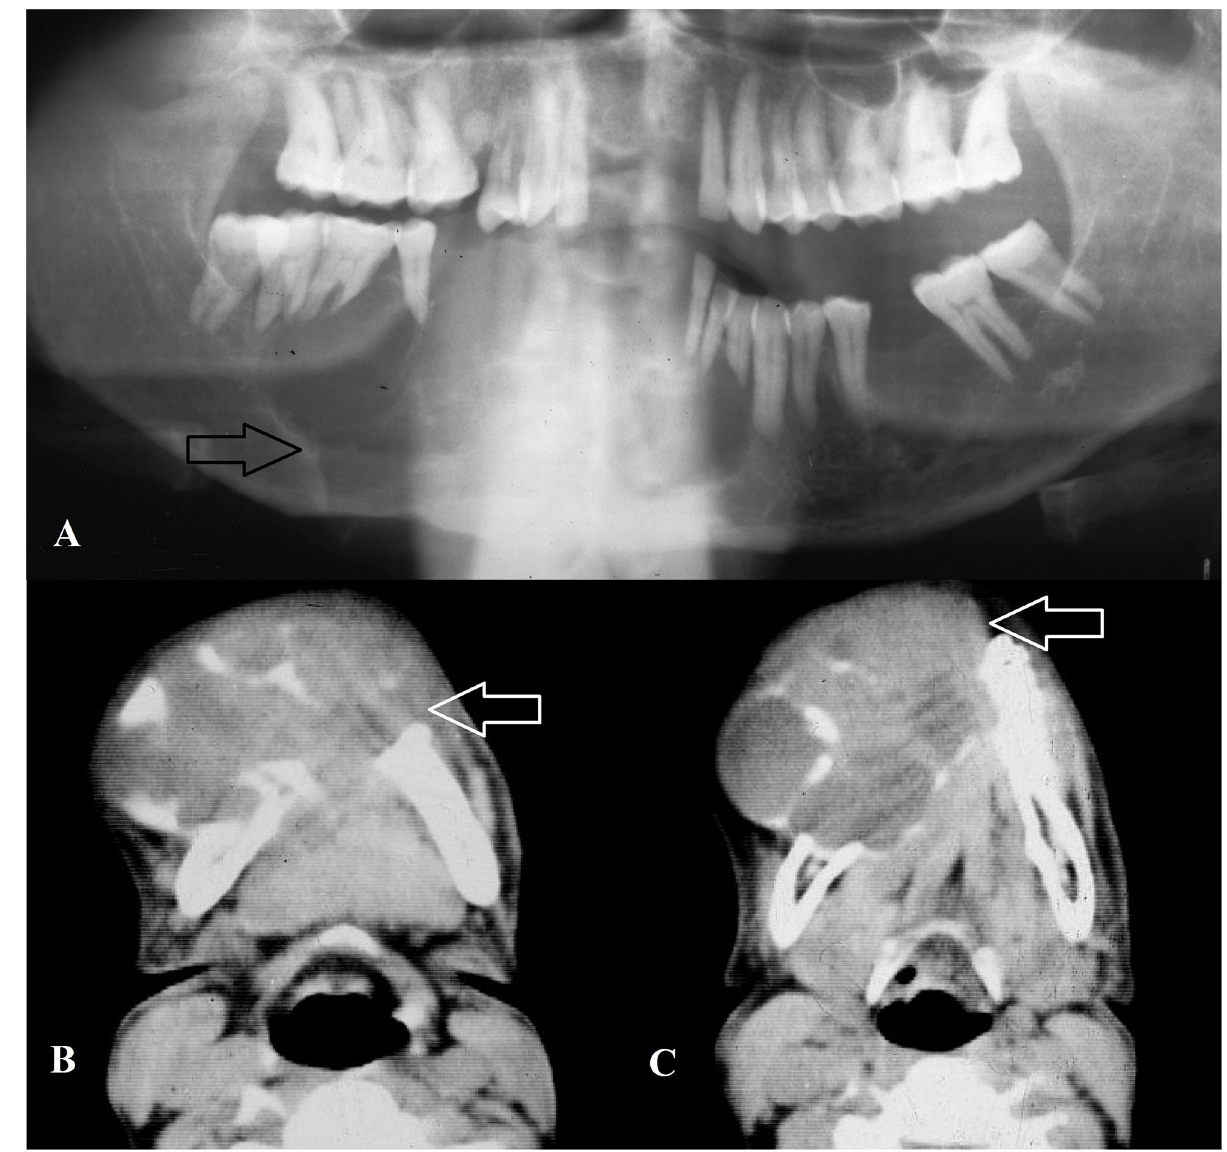
Fig 3. A : Panoramic radiograph showing destructive, ill-defined squamous cell carcinoma arising from the epithelial lining of residual cyst in the mandible. B and C : Axial computed tomography images of same patient showing invasive, expansive and multilocular lesion in the mandible.